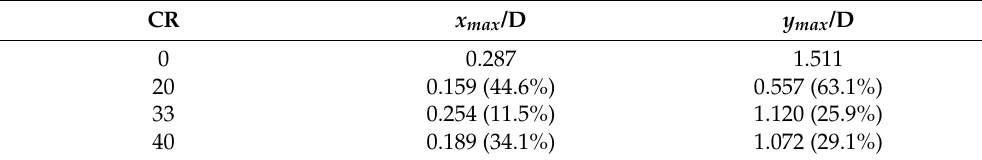
Table 3. The maximum vibration amplitude of a cylinder with surface bulges at different coverage ratios CR (cid:2206) (cid:2195)(cid:2183)(cid:2206) (cid:1778)⁄